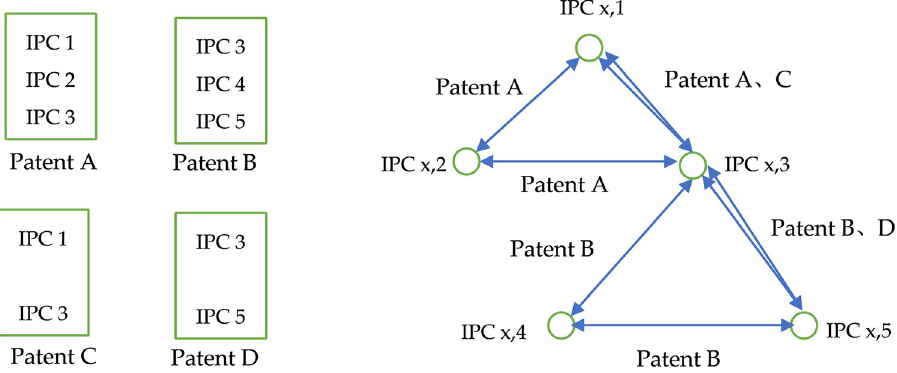
Fig 3. Technology convergence